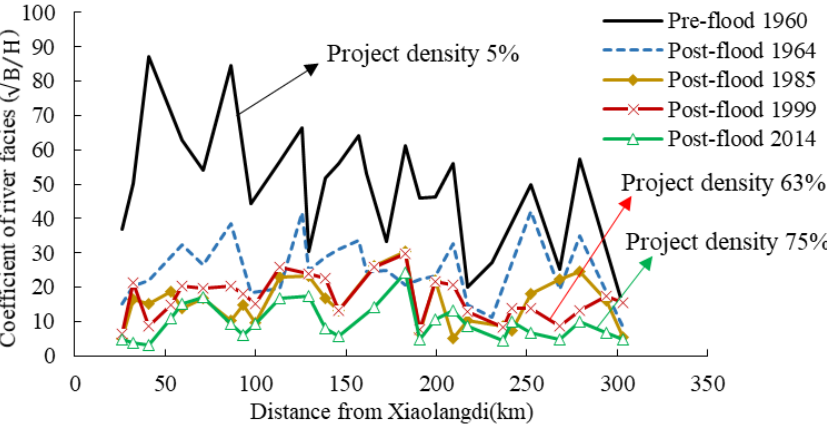
Figure 9. Variation in the river facies coefficient in the lower Yellow River in different periods.